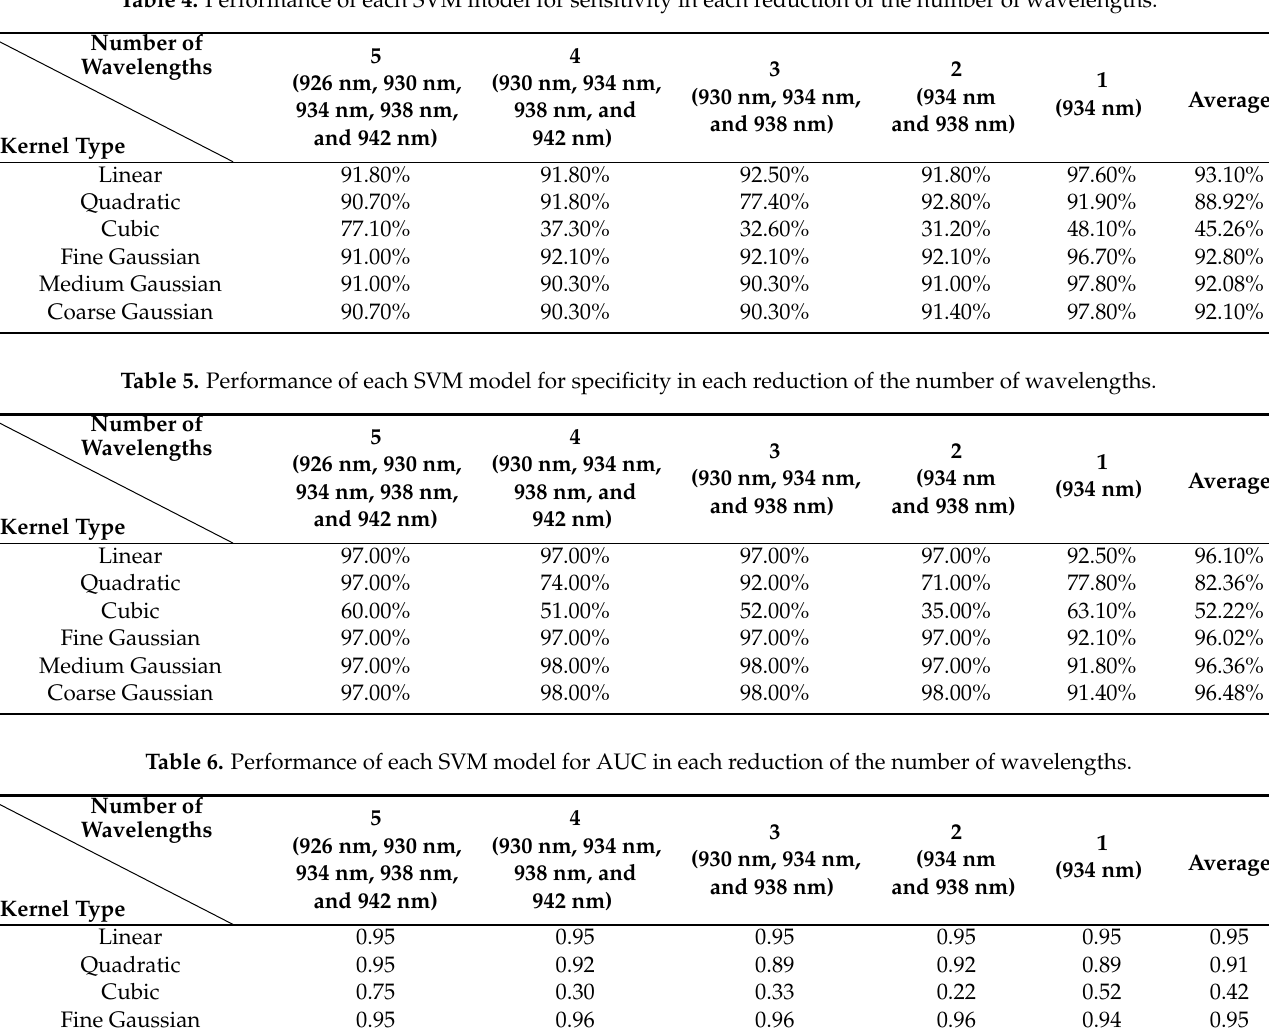
Table 4. Performance of each SVM model for sensitivity in each reduction of the number of wavelengths.